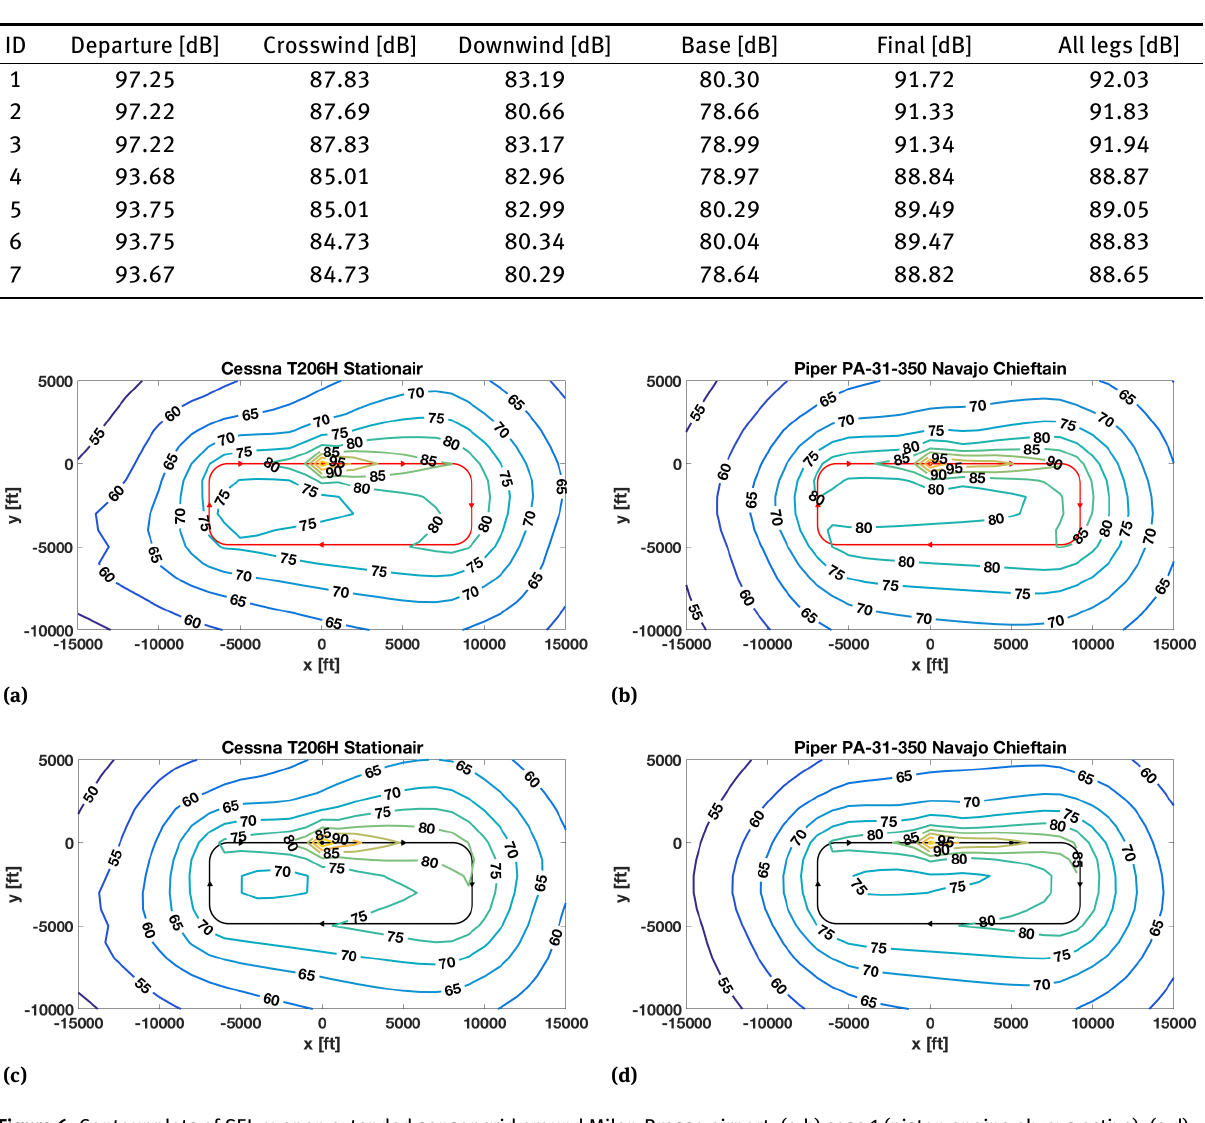
Table 8: Average SEL for the Piper PA-31-350 Navajo Chieftain. Results for conditional activation cases listed in Table 6.